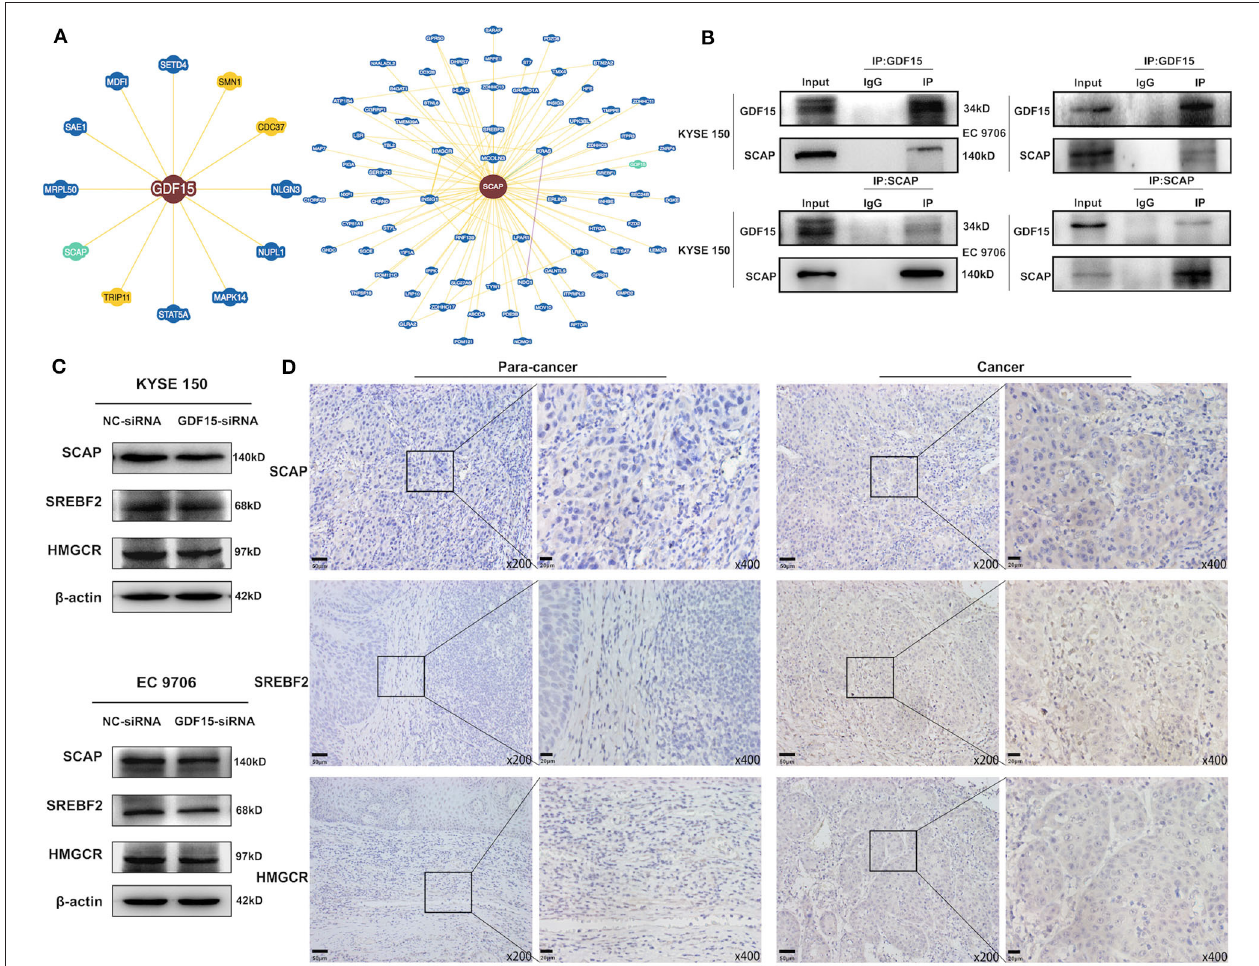
FIGURE 3 | Identification of GDF15–SCAP protein interactions. (A,B) Analysis of protein interactions between GDF15 and SCAP using the BioGRID database. CoIP assays were used to verify these interactions. (C) SCAP, SREBF2, and HMGCR expression levels in GDF15-siRNA ESCCs determined by western blotting. (D) SCAP, SREBF2, and HMGCR expression levels in EC and adjacent tissues determined by